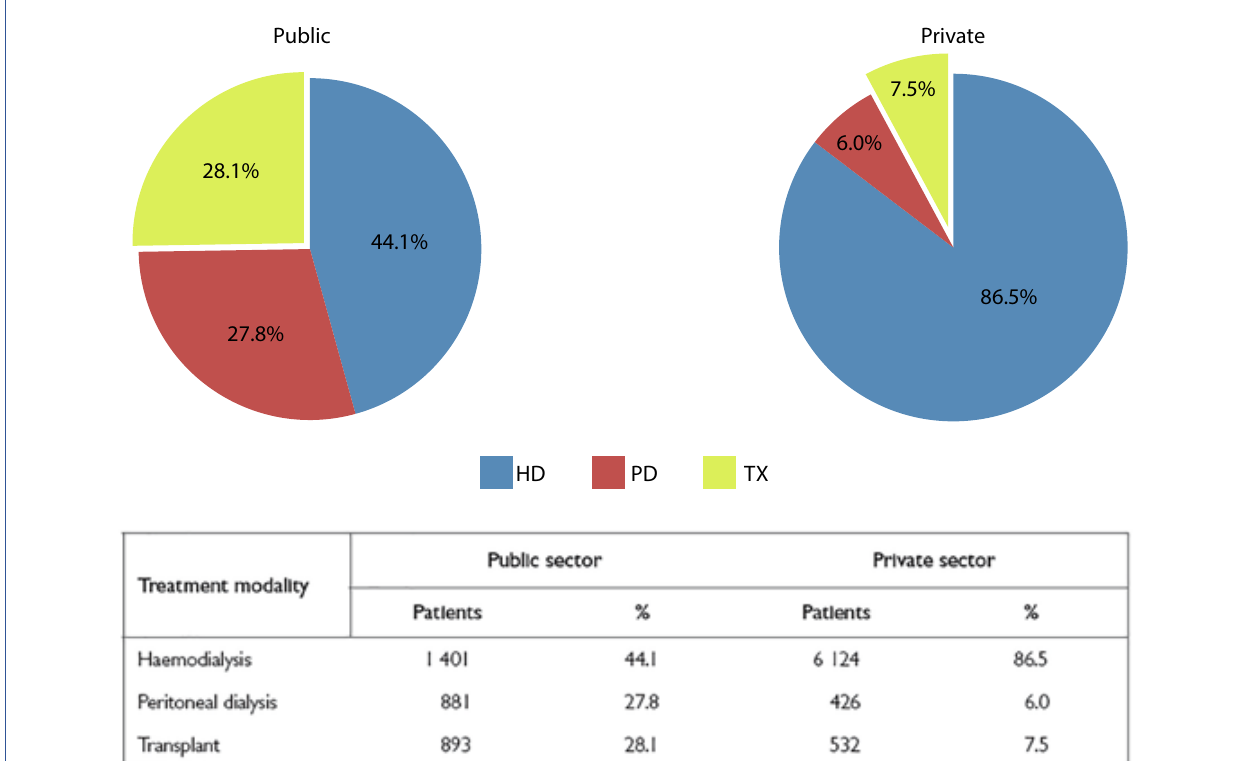
Figure 2. Renal replacement therapy in South Africa, by treatment modality and healthcare sector.